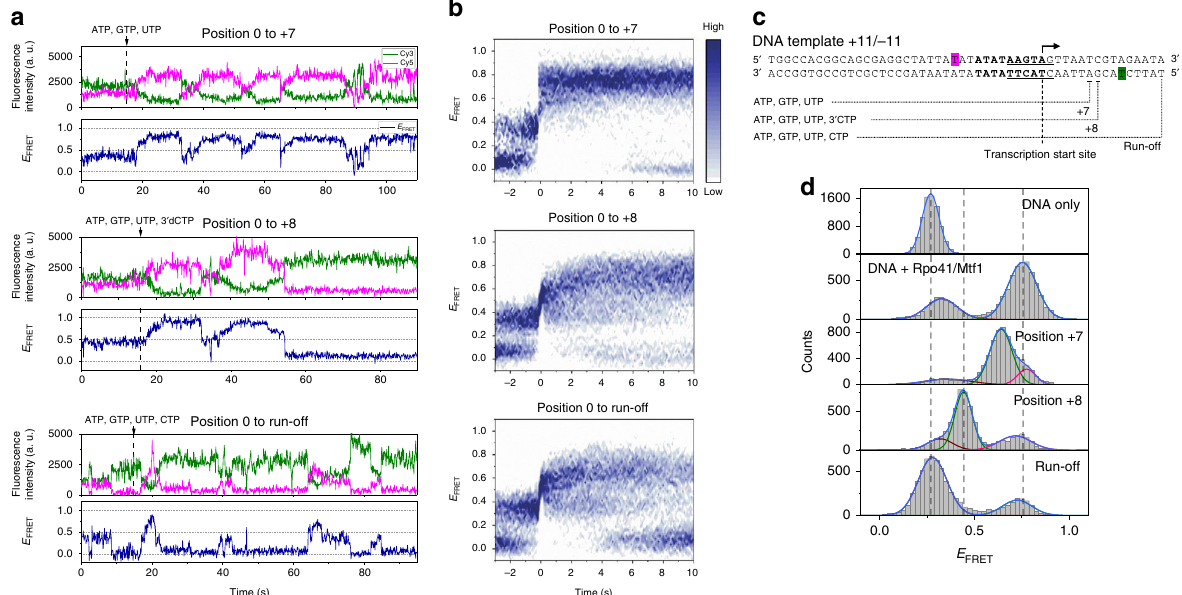
Fig. 2 Transition to elongation occurs via a large, abrupt conformational change at position + 8. a Representative smFRET traces from fl ow-in measurements. The point at which combinations of NTPs were added to stall the initiation complex at position + 7 or + 8, or to enable run-off is shown as a vertical dotted line. b FRET evolution maps constructed by overlaying multiple traces synchronized at the moment the FRET signal reached 0.5 (0 s). The 176, 181, and 160 traces were used to generate maps for progression to positions + 7 and + 8 and run-off, respectively. c Schematic design of DNA template + 11/ − 11 used to distinguish between the conformations of the elongation complex and DNA only. d FRET histograms from DNA template + 11/ − 11. Single, double, or triple Gaussian fi tting to each histogram is shown (Supplementary Table 1). Dashed vertical lines mark the major FRET peaks of DNA only, DNA + Rpo41/Mtf1, and the complex at position +